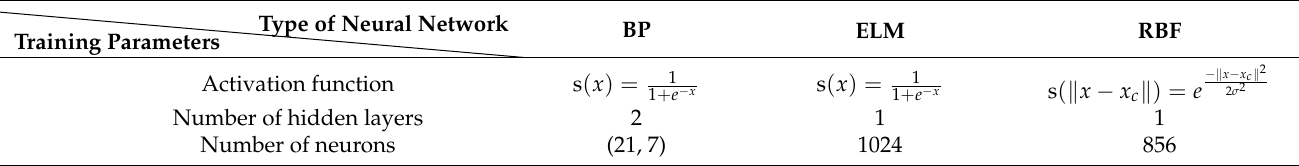
Table 5. The parameters of the three neural networks.